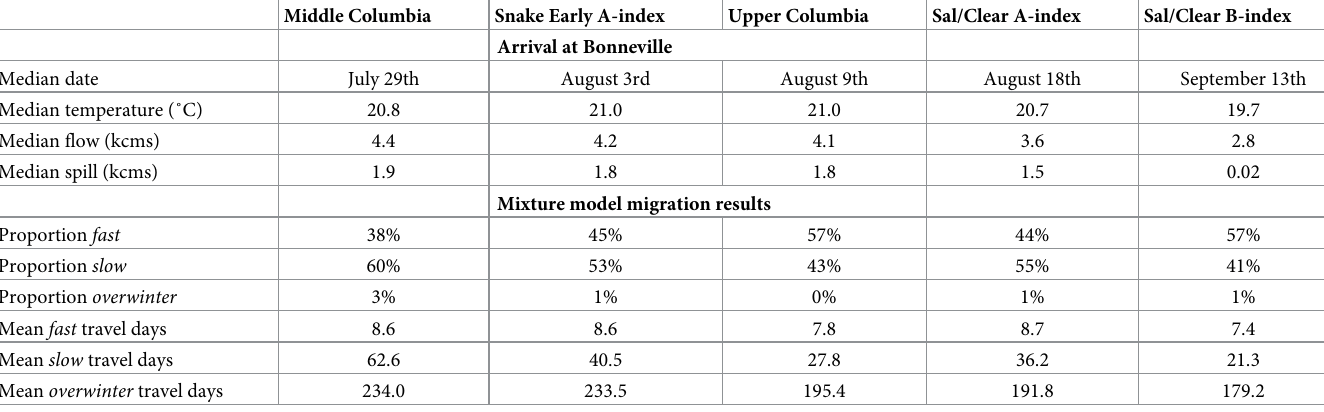
Fig 3. Arrival date distributions by population group and the river environment. Arrival dates for population groups (boxplots) plotted with mean daily values (solid lines) and associated bands for ± one standard deviation (dotted lines) for temperature, spill, and flow at Bonneville Dam for the study period 2004–2016. https://doi.org/10.1371/journal.pone.0250831.g003 likely to delay ( slow or overwintering behaviors, 63%), followed by the Sal/Clear A-index (56%), the Snake Early A-index (54%), the Upper Columbia (43%), and the Sal/Clear B-index (42%) (Table 1, Fig 4A–4E). The majority of delayed individuals were categorized as slow migrants, with the estimated percent of overwintering fish ranging from a high of 3% in the Middle Columbia populations to being largely non-existent in the Upper Columbia Table 1. Median arrival conditions and predicted behavior distributions by population